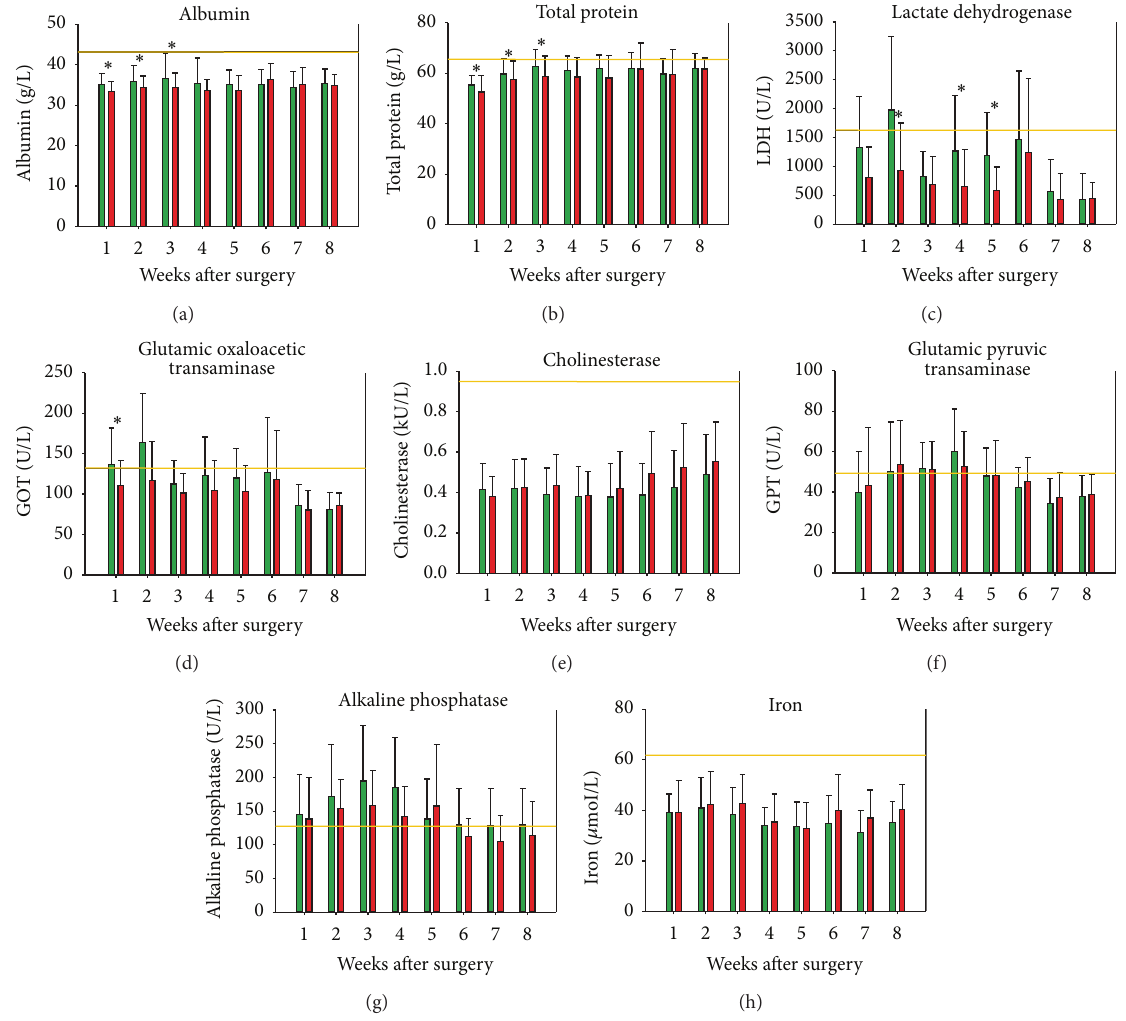
Figure 4: Serum levels of albumin (a), total protein (b), LDH (c), GOT (d), CHE (e), GPT (f), AP (g), and iron (h) in weeks one to eight after surgery. Data are expressed as mean ± standard deviation. Orange lines show normal standard values without toxic liver damage, green bars demonstrate values of cell treated animals, and red bars values of noncell treated control animals. Significant data sets are indicated with